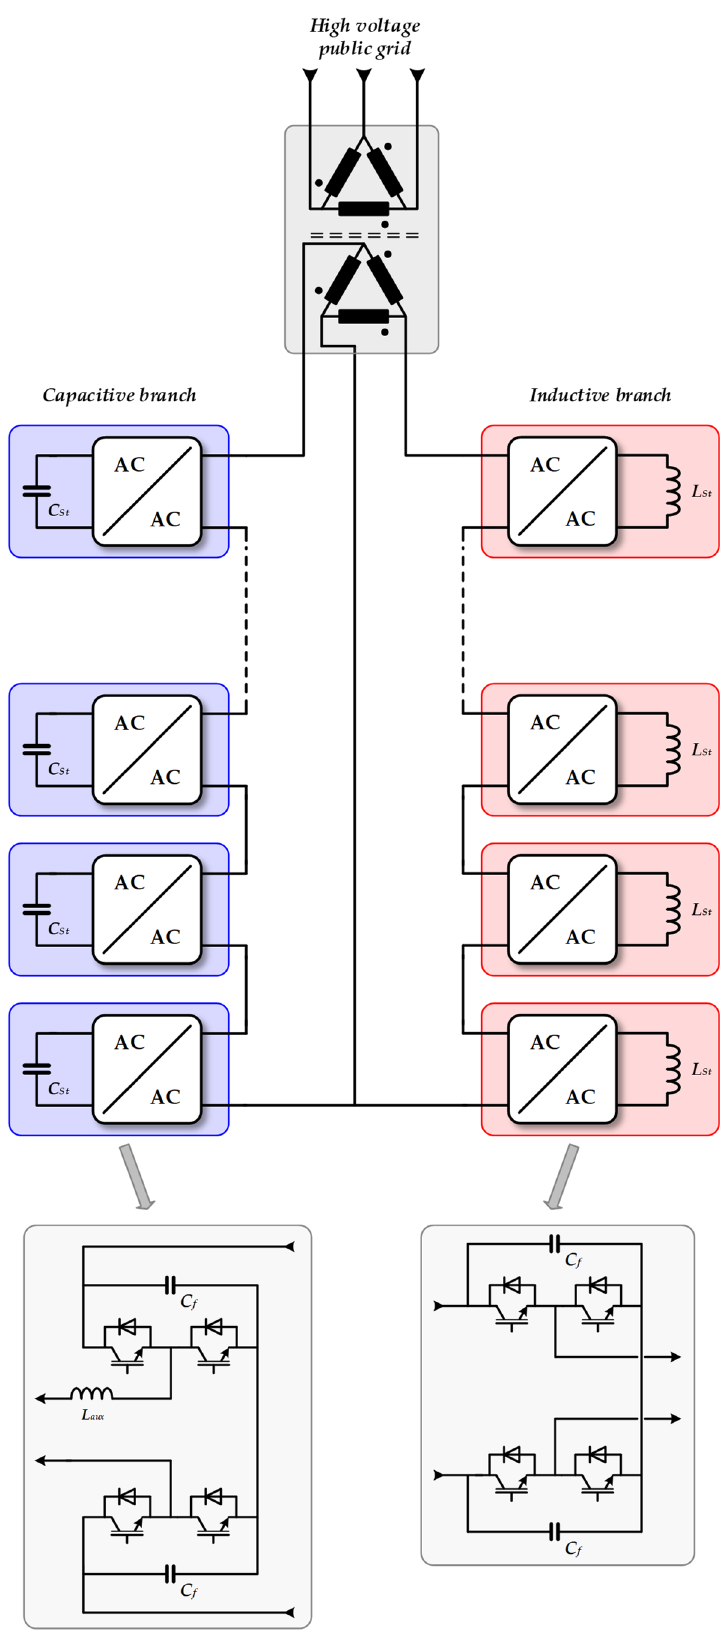
Figure 8. Topology of the active Steinmetz balancing system.